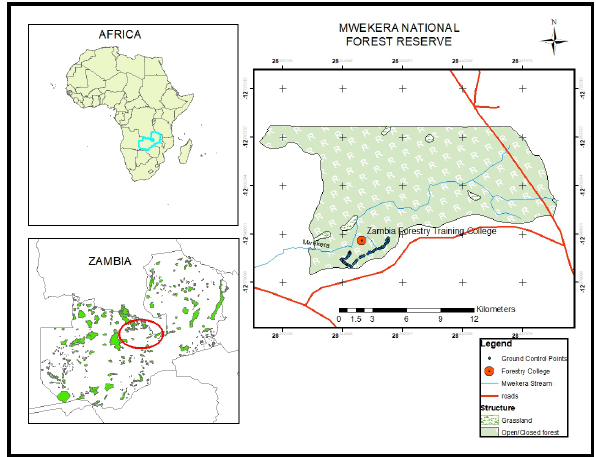
Figure 1. Study area